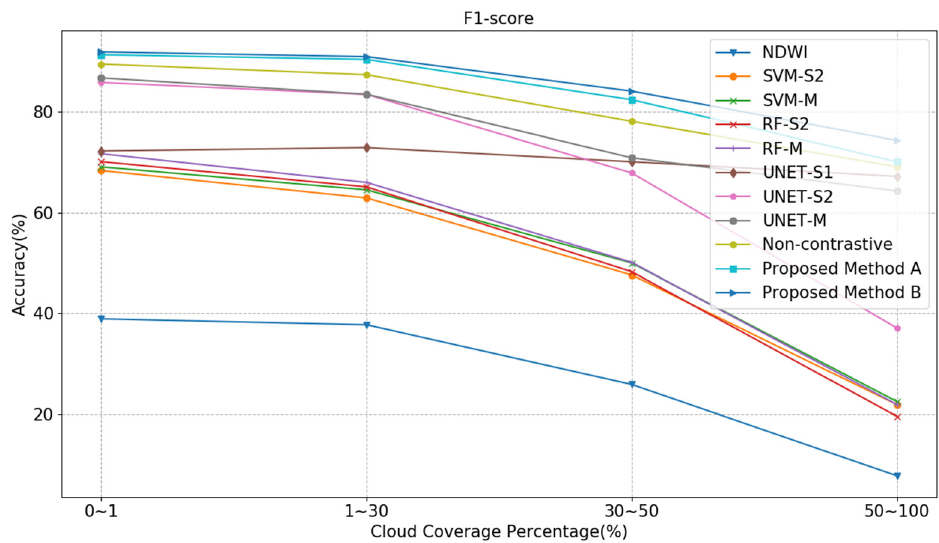
Figure 10. The performance of the proposed method and other state-of-the-art methods on large-scale river segmentation under different cloud coverage percentage condition.